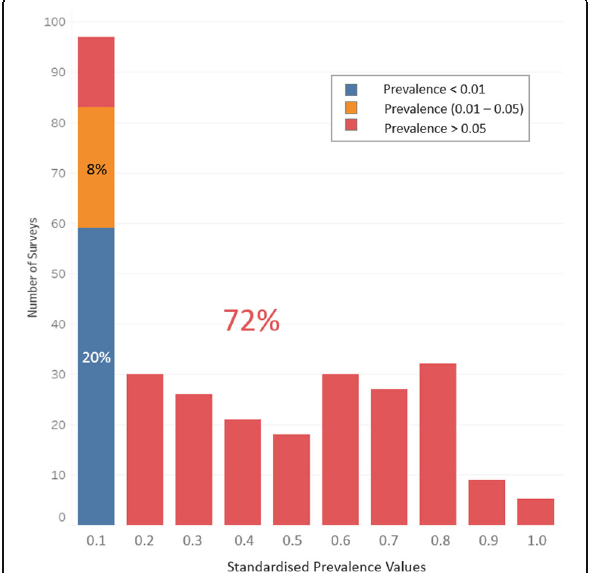
Fig. 4 Distribution of surveys according to their standardised prevalence values. Seventy-one out of 295 surveys had their prevalence values predicted using model B1. The three colours shown represent each of our prevalence categories: blue — no prevalence (<0.01), orange — low prevalence (0.01 – 0.05) and red — high prevalence (>0.05), with their respective